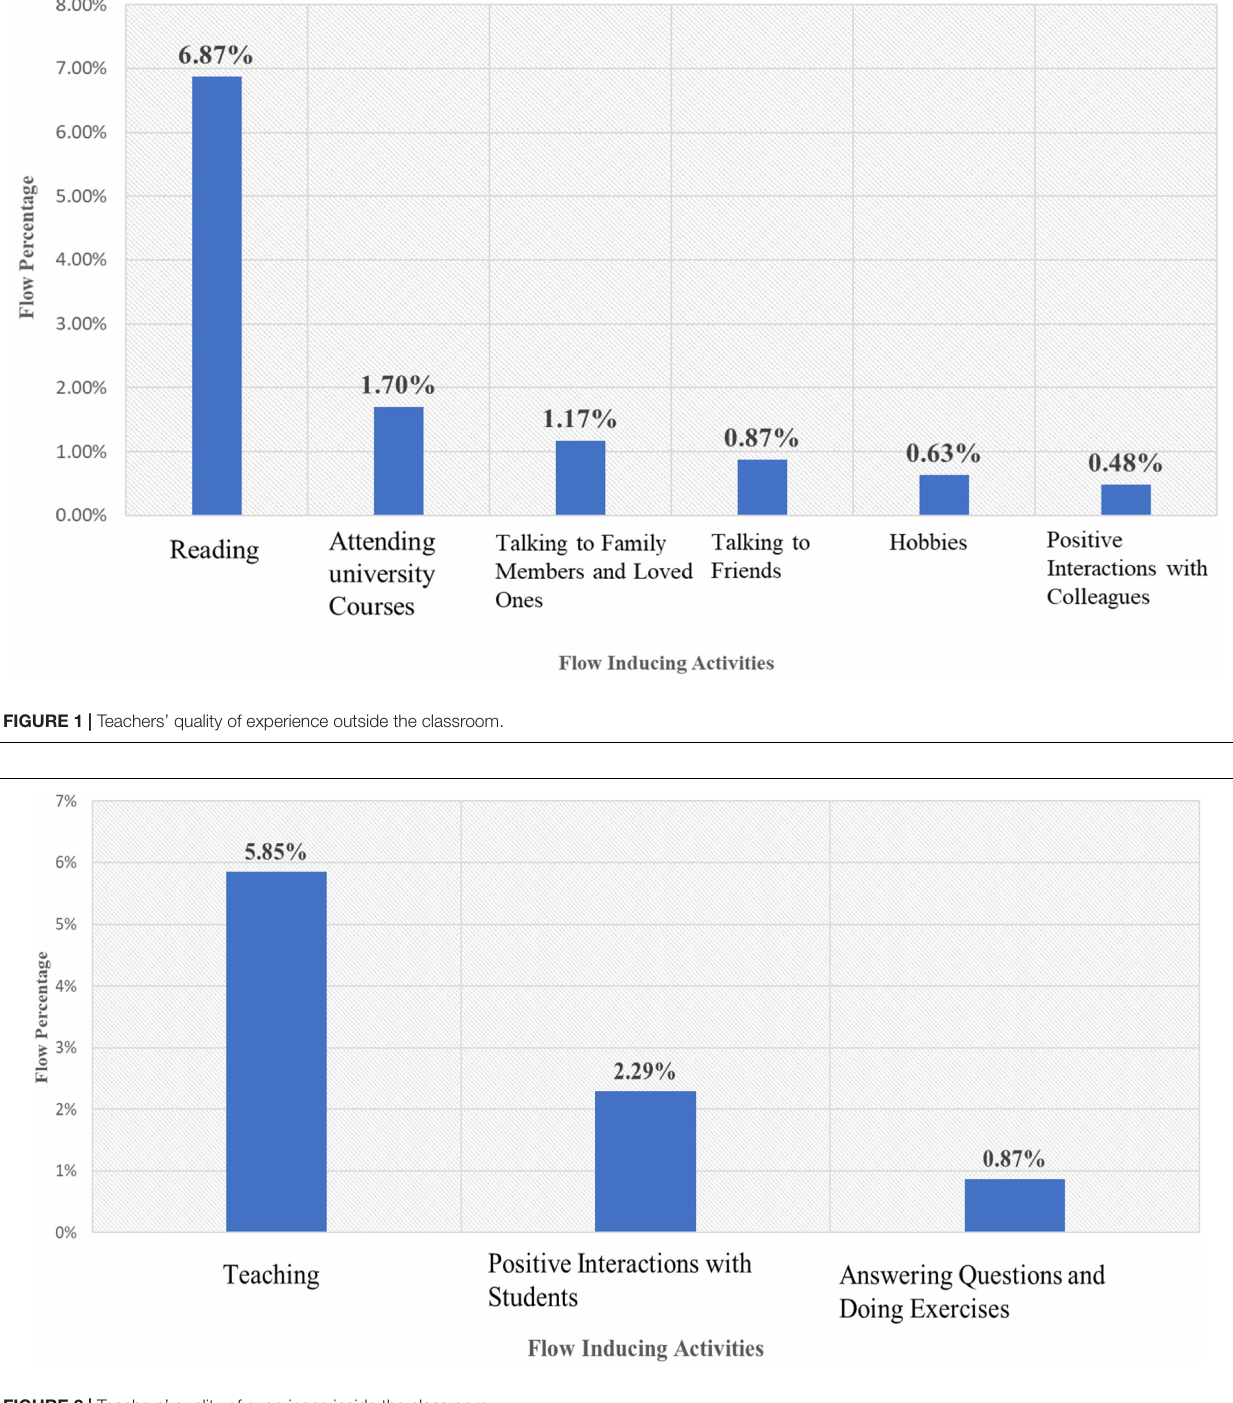
FIGURE 2 | Teachers’ quality of experience inside the classroom.